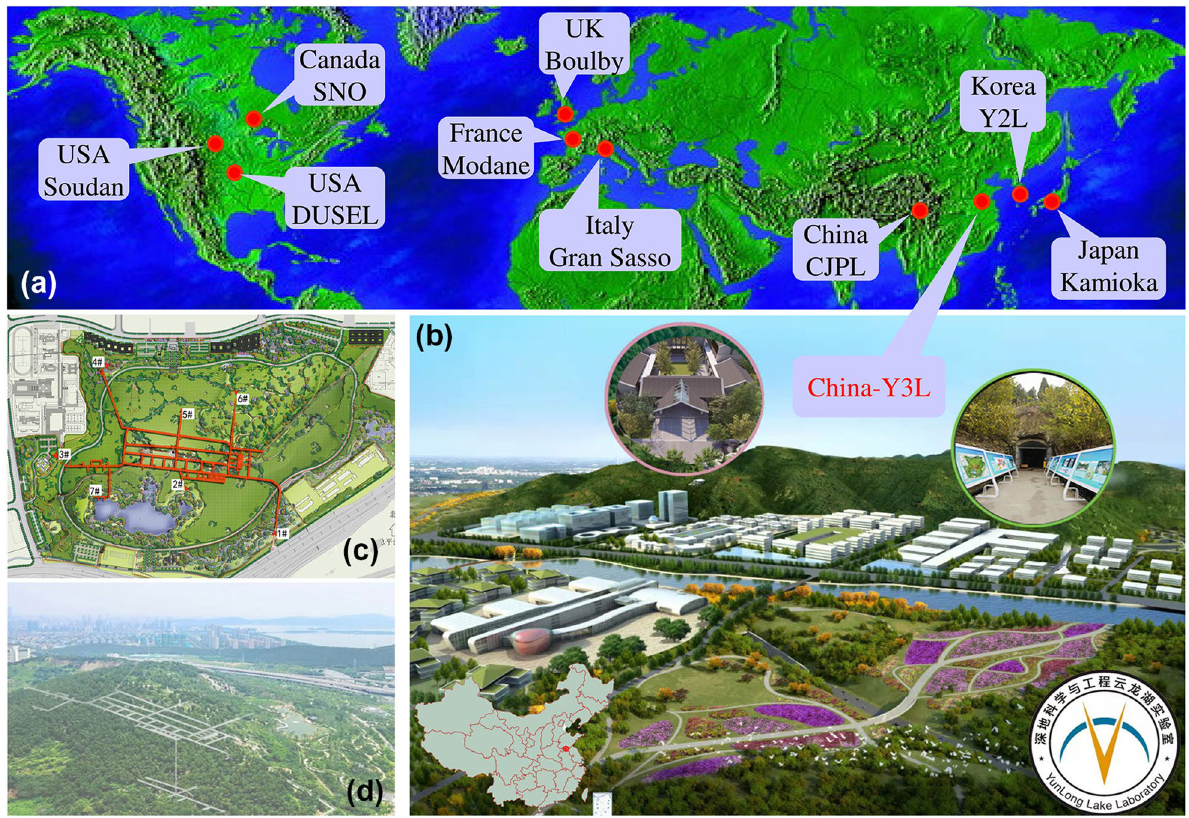
Fig. 1 Typical deep underground labs all over the world ( a ) as well as the artist’s rendition and layout of the Y3L ( b – d ) near Xuzhou’s scenic YunLong